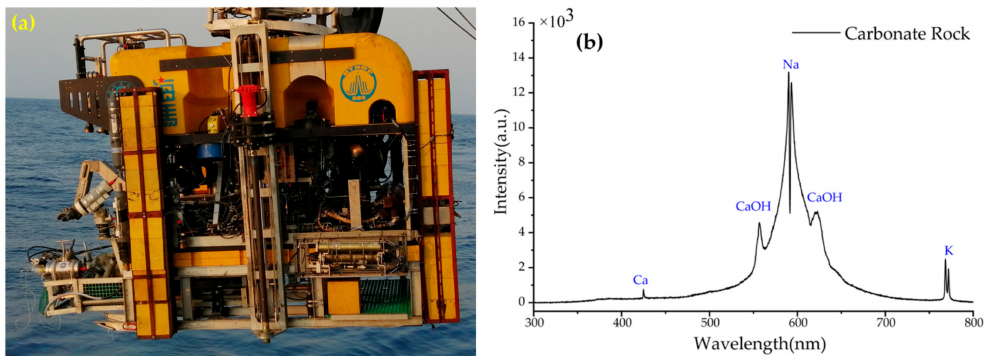
Figure 7. ( a ) LIBSea II mounted on the Haima ROV for in-situ experiments in the Haima cold seep area ( b ) Typical spectra of carbonate rock measured in deep